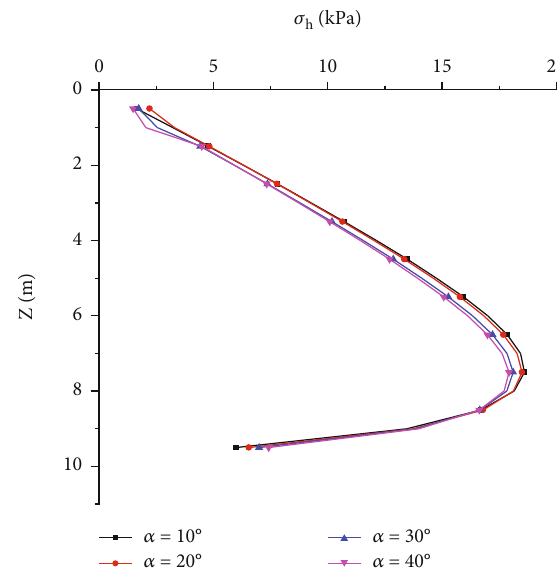
Figure 9: Distribution of active earth pressure under di ff erent α ( l / H = 0 : 1 ).